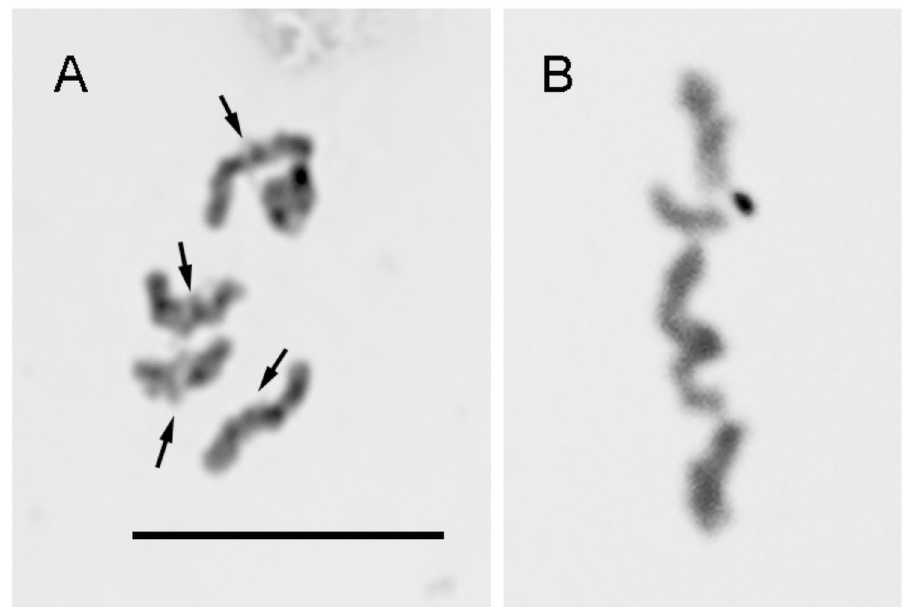
Fig 3. Giemsa-stained bivalents. A. In the wild type, kinetochores (arrows) are often seen to project from chromosomes, indicating pulling by spindle microtubuli. B. This was never observed in the mutant when chromosomes were similarly compacted. Bivalents are not strictly arranged in tandem due to the breaking of the nuclear membrane caused by this method. Bar: 10 μ m.